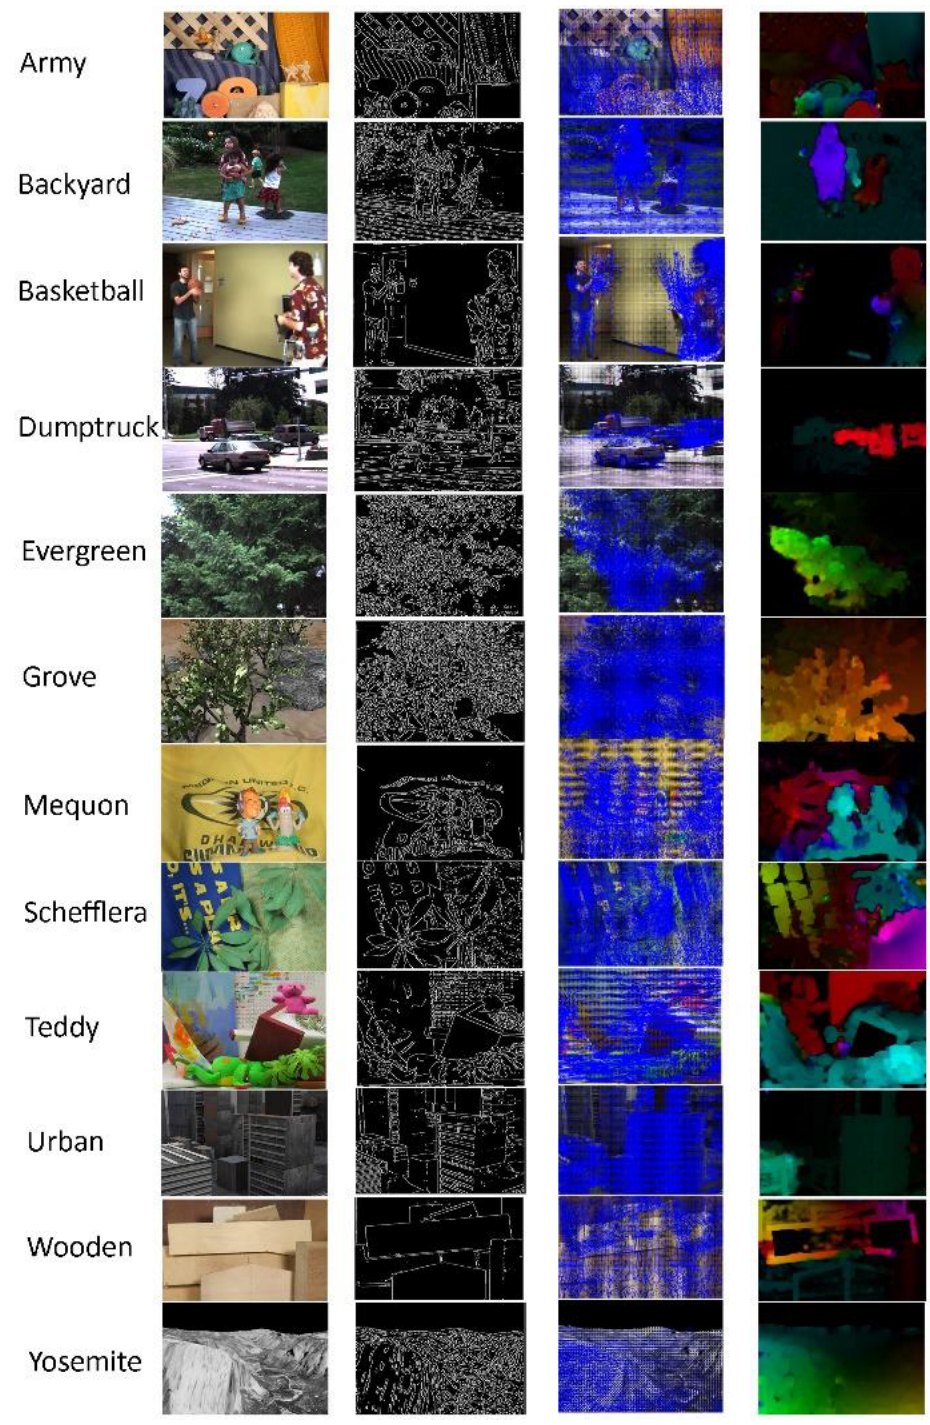
Figure 4. Results of optical flow estimation tested in the Middlebury Dataset .